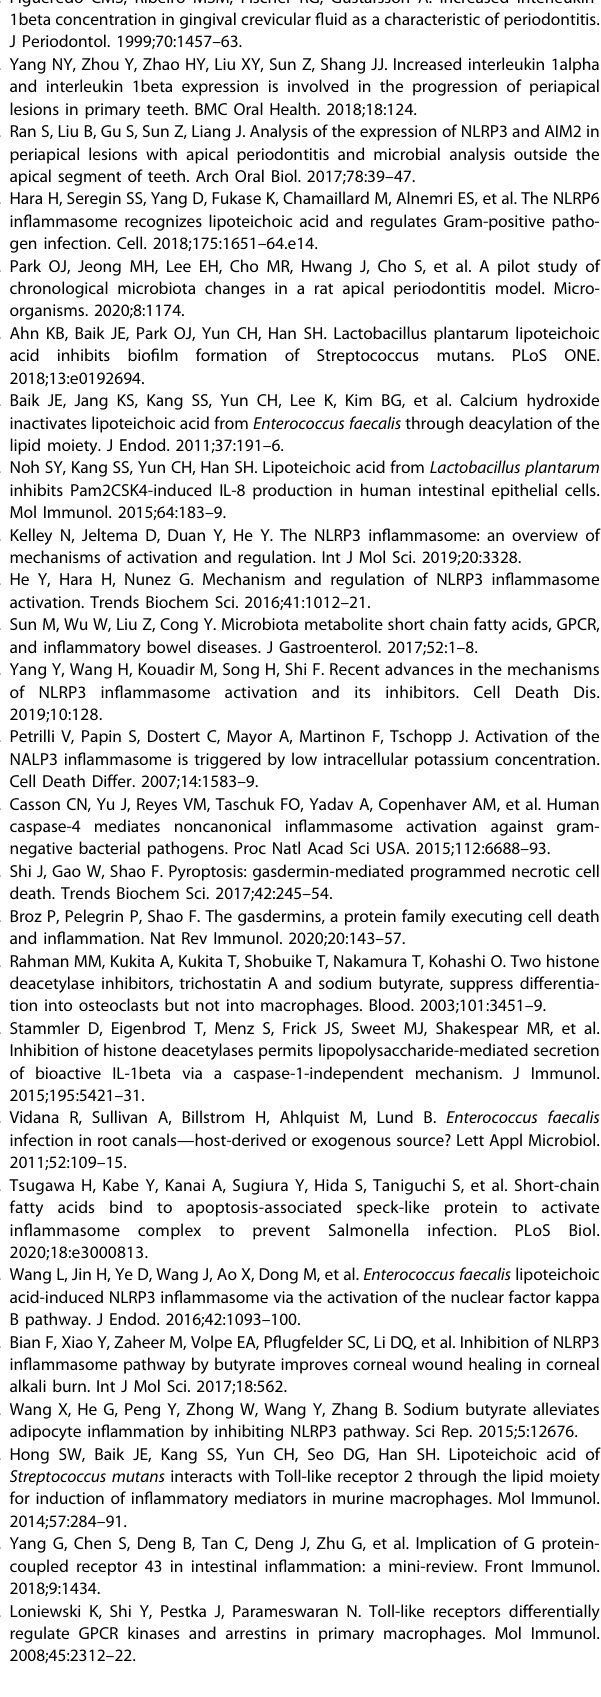
20. Figueredo CMS, Ribeiro MSM, Fischer RG, Gustafsson A. Increased interleukin- 1beta concentration in gingival crevicular fl uid as a characteristic of